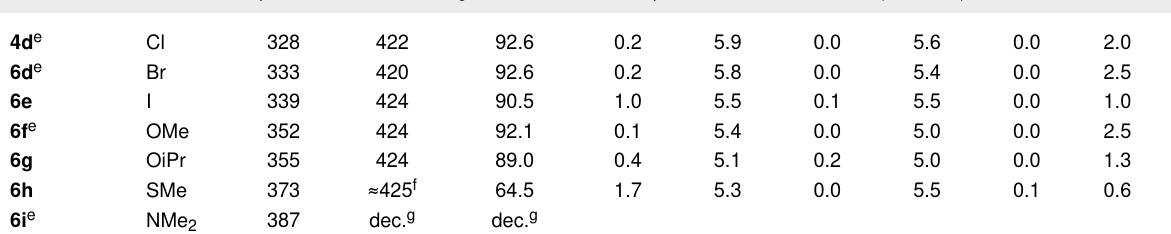
Table 3: Structure and results of photochemical and binding characterization of compounds 3e , 4d , 6b and 6d–i . (continued) 4d e